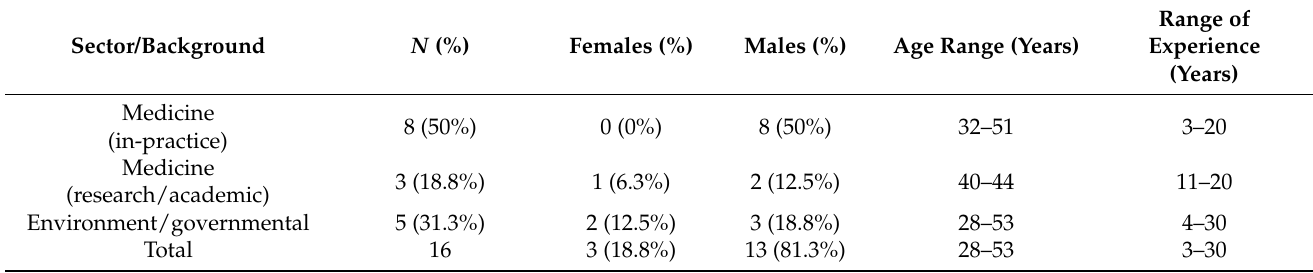
Table 1. Descriptive characteristics and participant profiles of the key informants interviewed in this study.